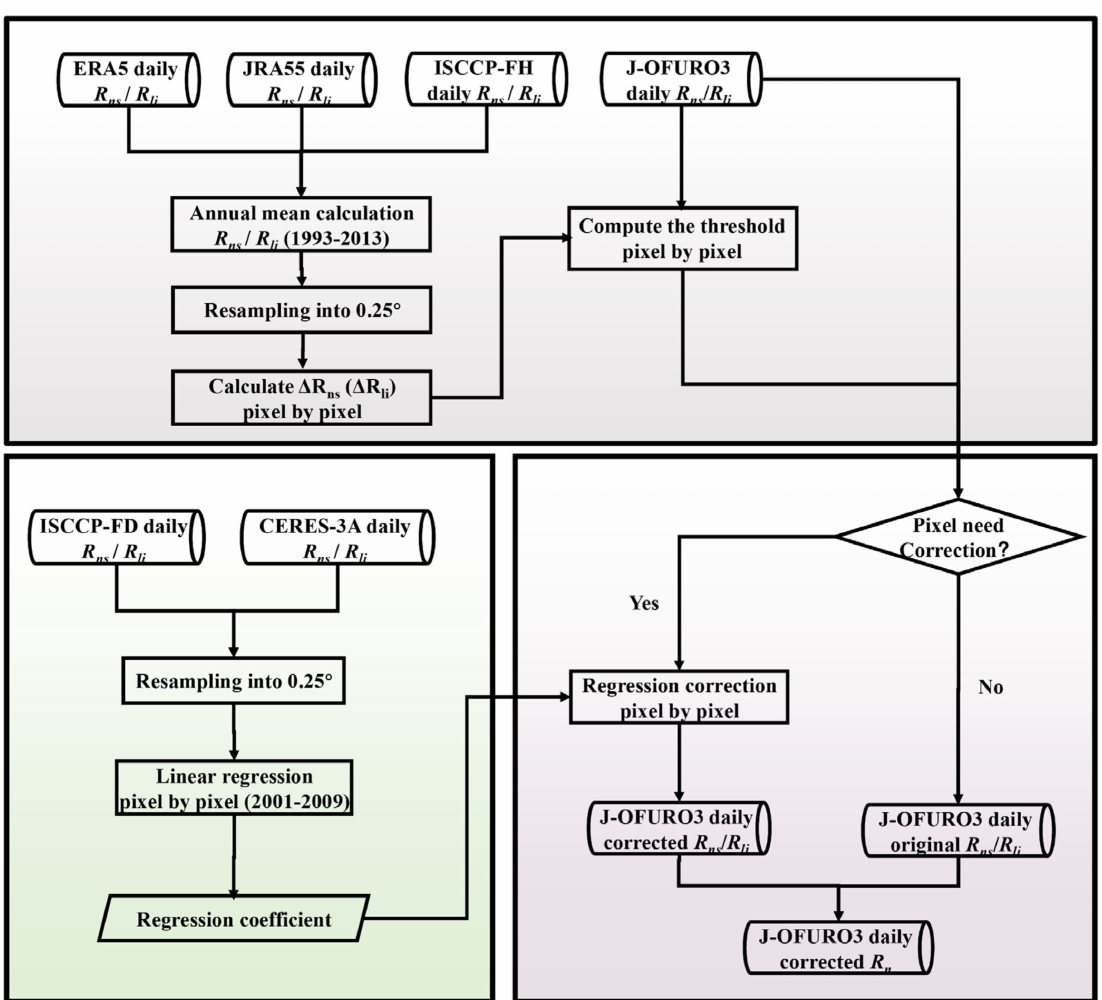
Figure 2. Flowchart of the inconsistency correction undertaken for the J-OFURO3 sea-surface R ns and R li